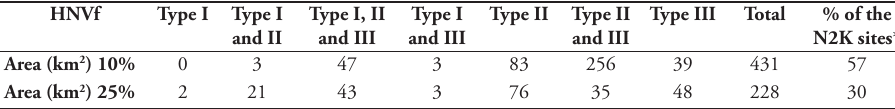
Table 3. HNVf types within the Natura2000 network.